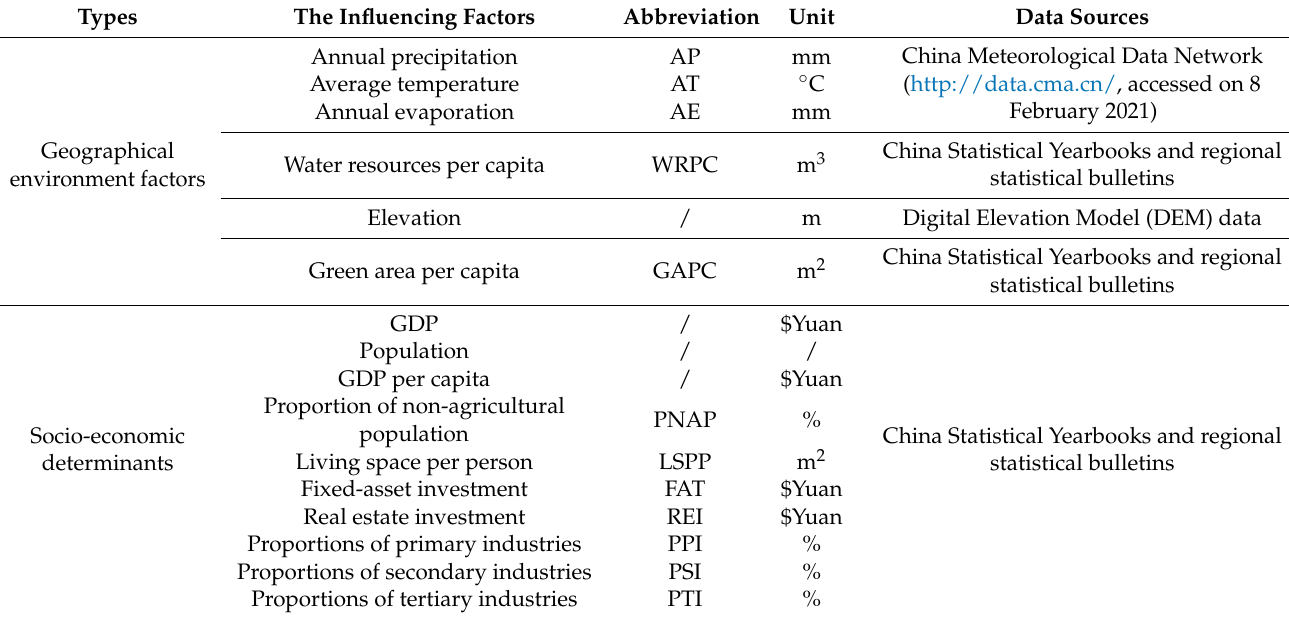
Table 1. Abbreviations and data sources of the influencing factors of green space. “/” represents the related influencing factors has no abbreviations or